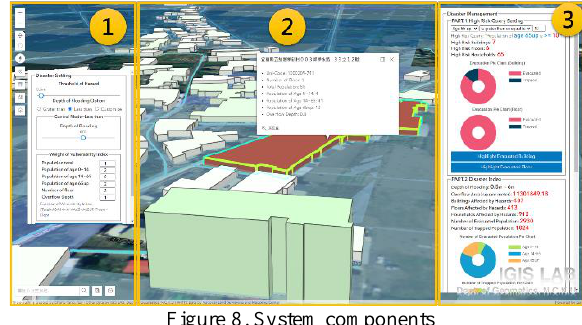
Figure 8. System components